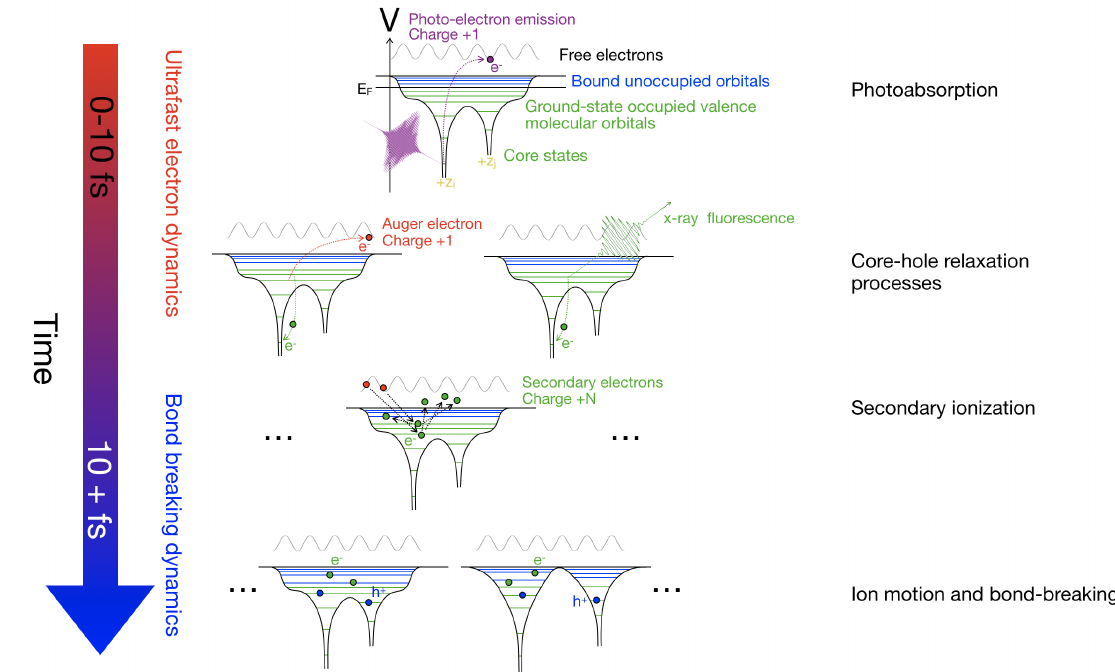
Figure 3. Schematic figure of relaxation processes and their approximate time-scales. The initial absorption of an X-ray photon results in the emission of a photoelectron, increasing the molecular charge by one. Heavier elements have a larger number of core-states than light elements, and the absorption cross-section is substantially higher, hence it is more likely for the primary photoabsorption event to occur on a heavier element (Section 2.1). Subsequently, the core-hole is relaxed. For elements lighter than arsenic, the Auger process is more likely (Section 2.2), the emission of the Auger electron further ionizes the molecule. The emitted electron scatters with bound electrons, producing cascades of low energy electrons. The higher electron density of heavier elements makes the cascade more common around a heavy nucleus (Section 2.3. Molecules consisting only of light elements have limited cascades. At this stage, the molecule can reach a highly ionized state. The photo-induced processes leads to ion dynamics, due to the loss of electrons, and the excited state populations, the molecular bonds might break (Section 2.4). The relaxation processes branch out to a large number of possible outcomes, contributing to the challenge of accurately simulating radiation